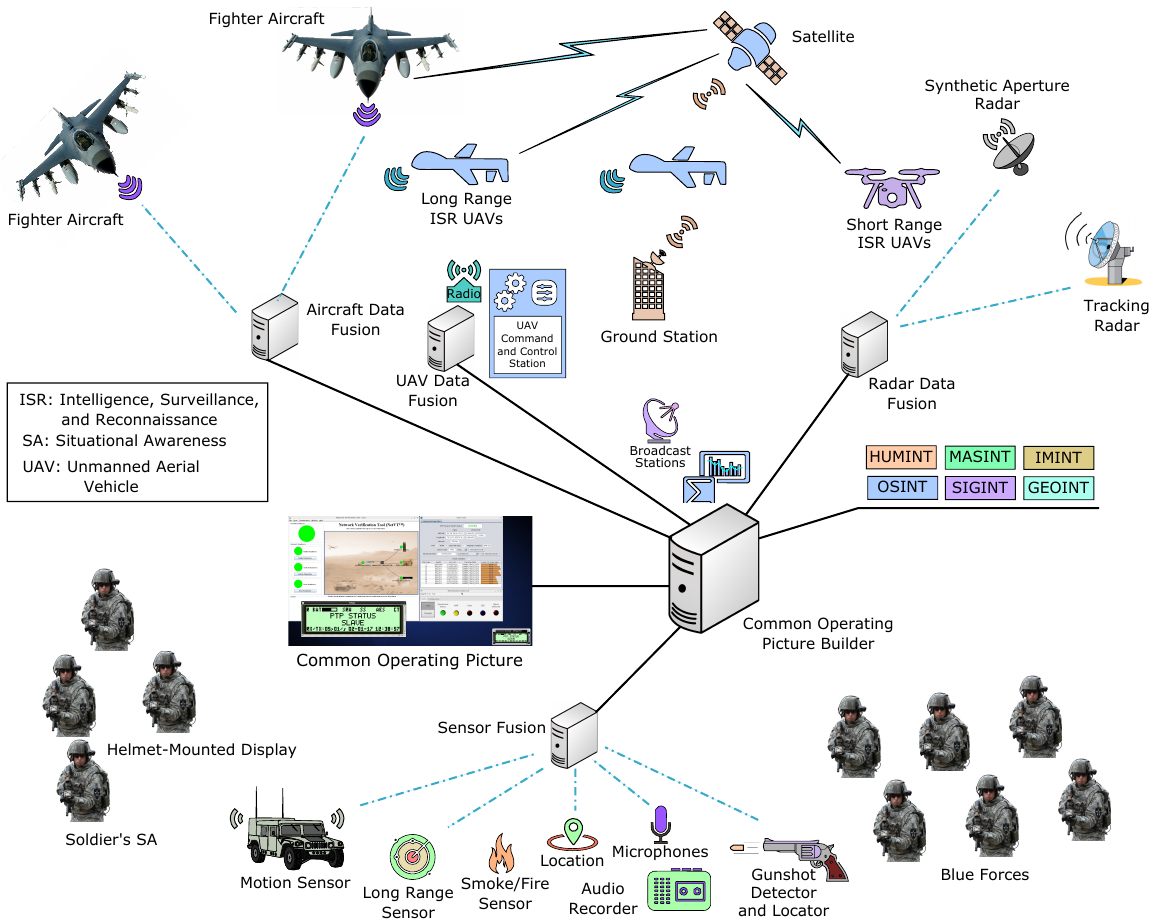
Figure 1. Overview of situational